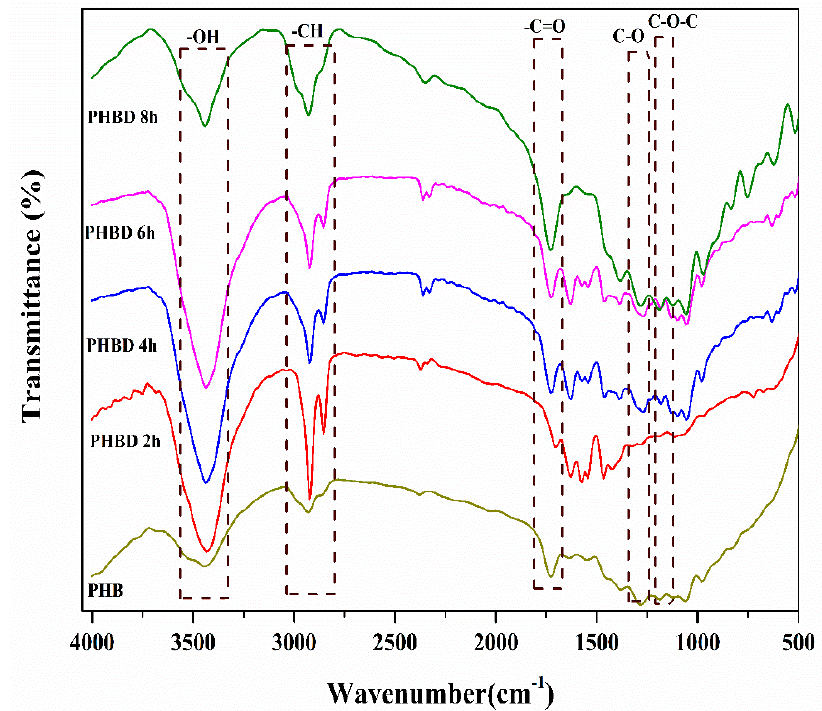
Figure 1. FTIR spectra of PHB and PHBDs obtained from different reaction time.